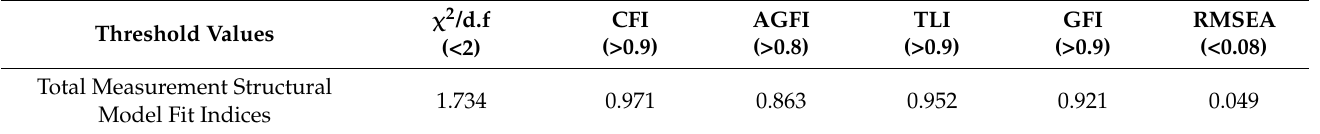
Table 3. Comparison of goodness-of-fit statistics of full measurement